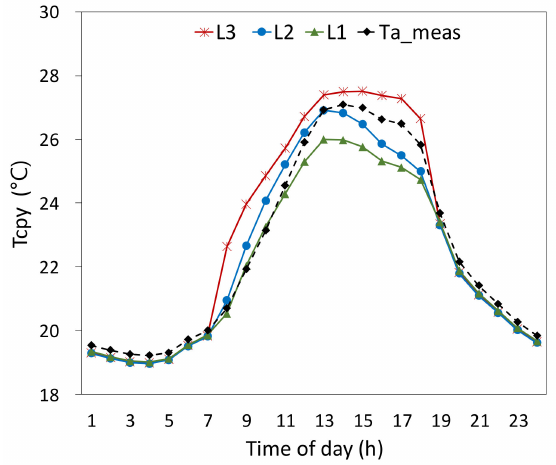
Figure 11. Canopy temperature calculated from Equation (33). A dependent variable, canopy temperature, is the result of calculations considering all independent variables from Equations (1)–(31) and Table 3. Ta_meas is the measurement of air temperature.